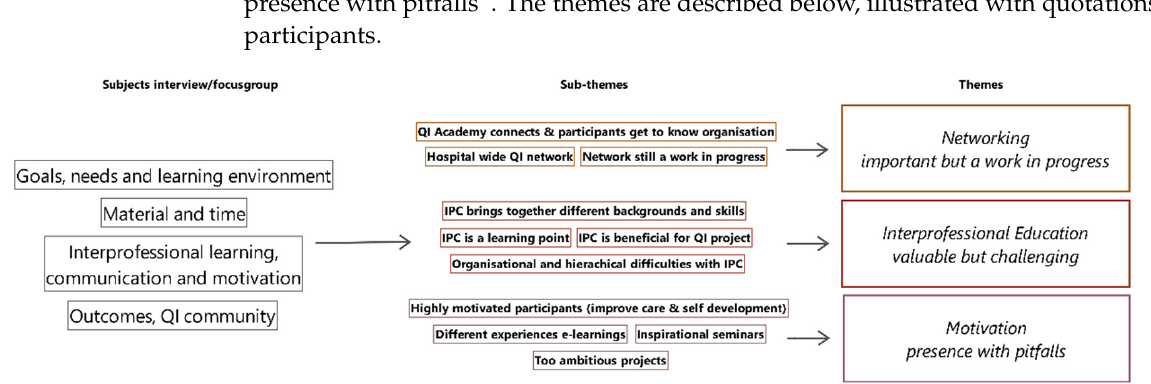
Figure 1. The three themes that emerged from the analysis .